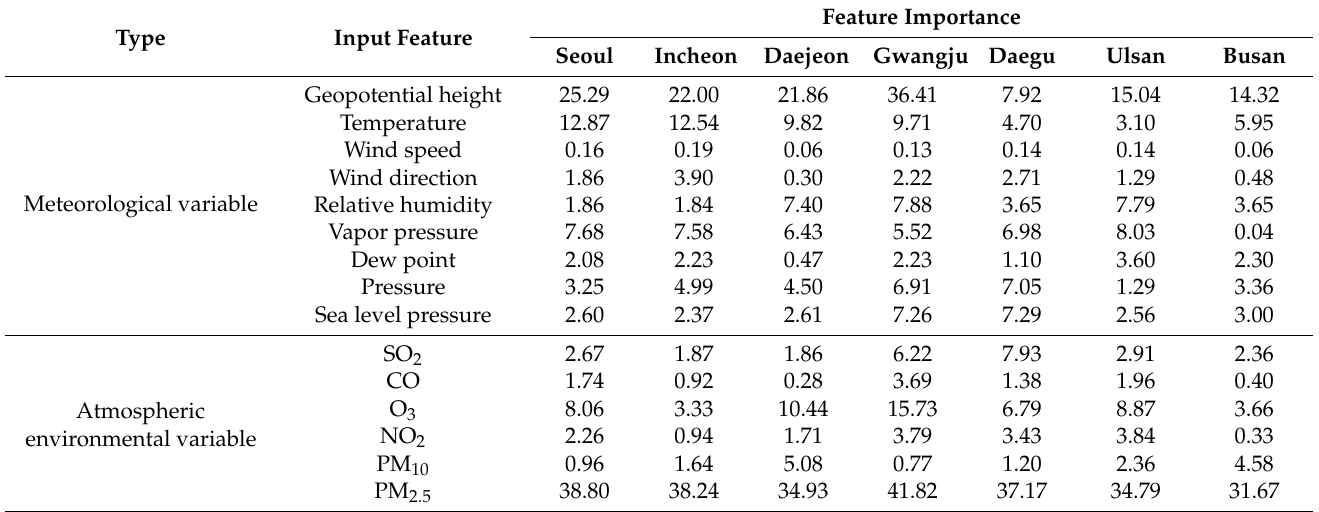
Table 6. Importance of the input features in daily PM 2.5 prediction